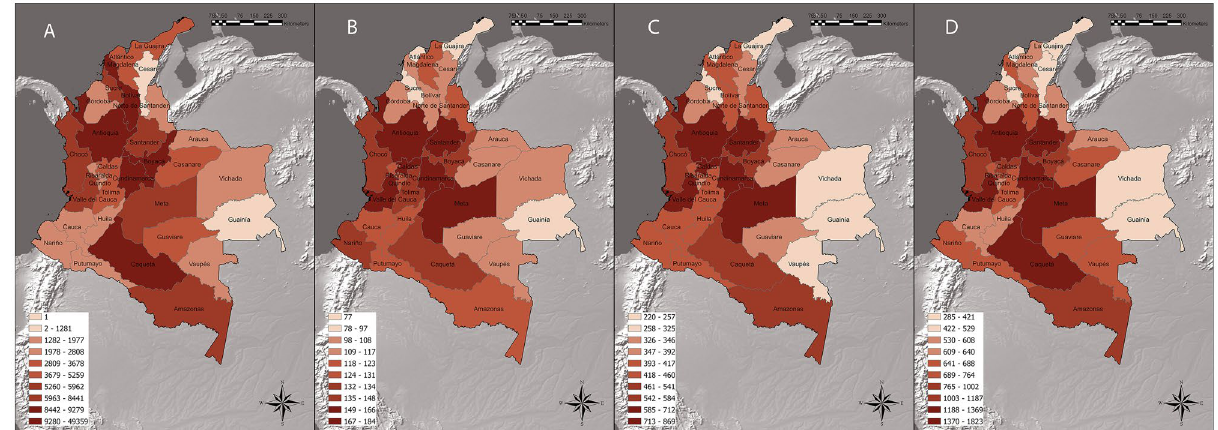
Figure 2. Distribution of Colombian edible plant species: ( A ) Number of unique occurrences per department; ( B ) Families richness per department; ( C ) Genera richness per department; ( D ) Species richness per